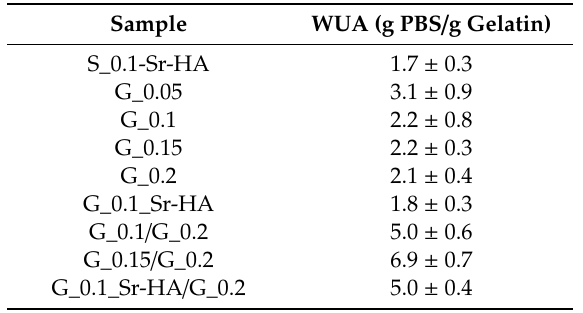
Table 3. Water Uptake Ability 1